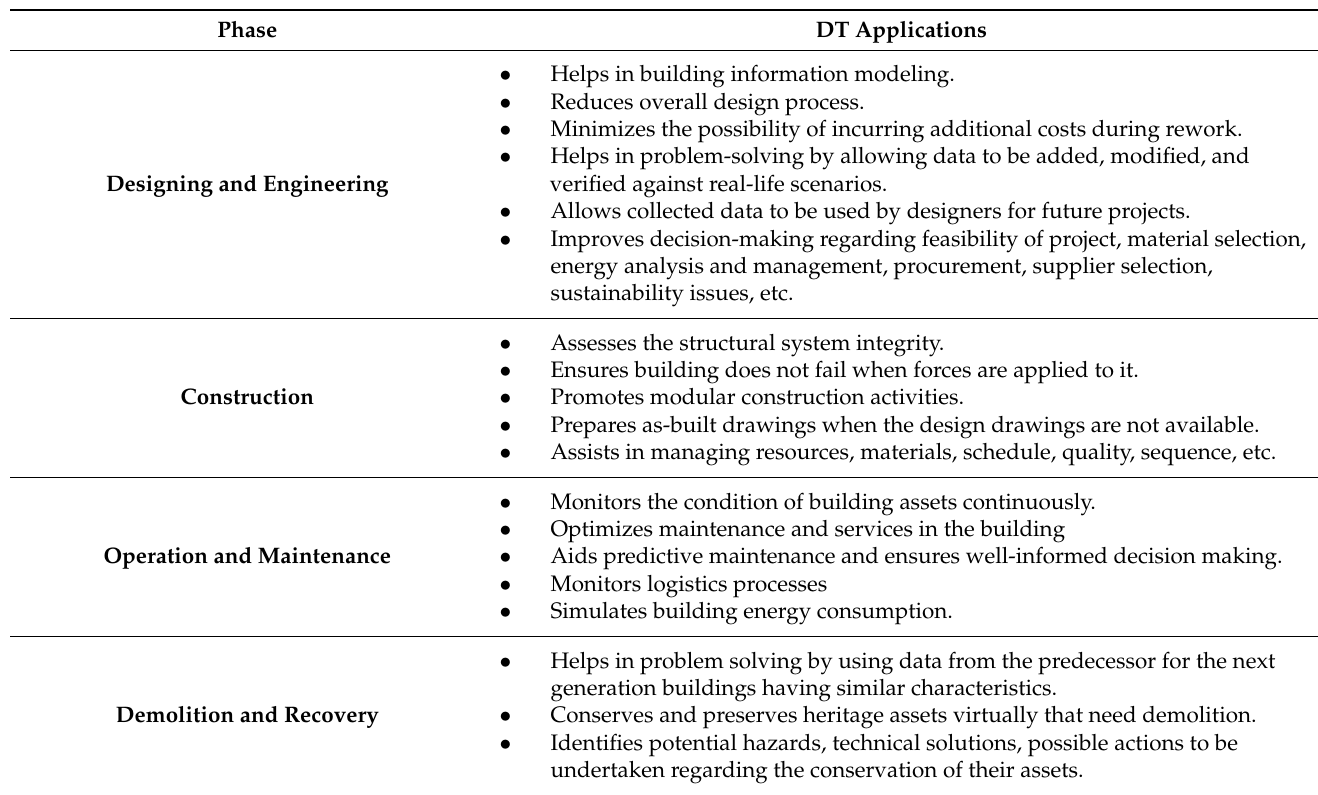
Table 2. Actual and potential applications of DTs in different phases of construction